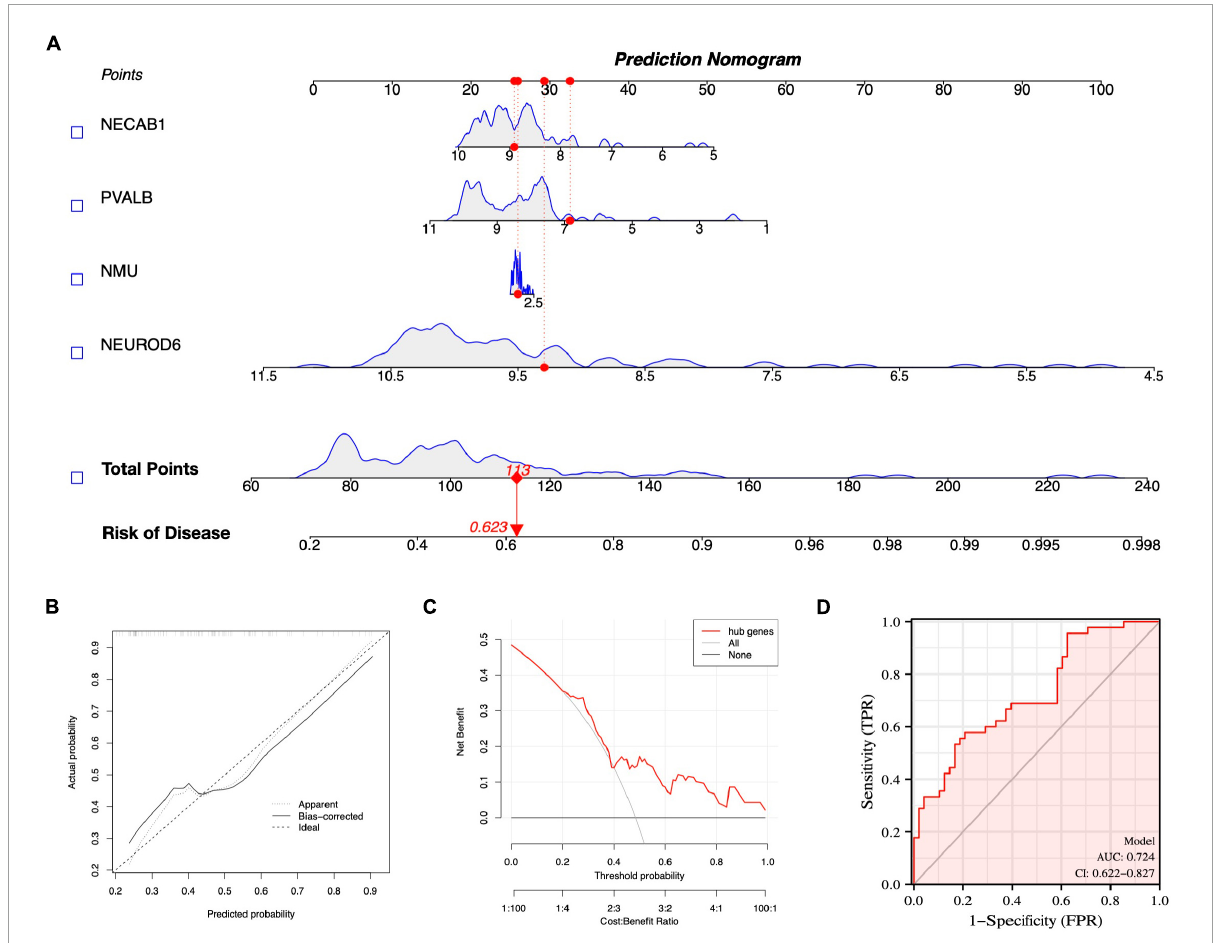
FIGURE10 Nomogram model construction for SCZ diagnosis. (A) Nomogram to predict SCZ risk. (B) Calibration curve evaluation for the diagnostic potential of the nomogram model. (C) DCA curve to assess the nomogram practical efficacy. (D) ROC curve to evaluate prediction